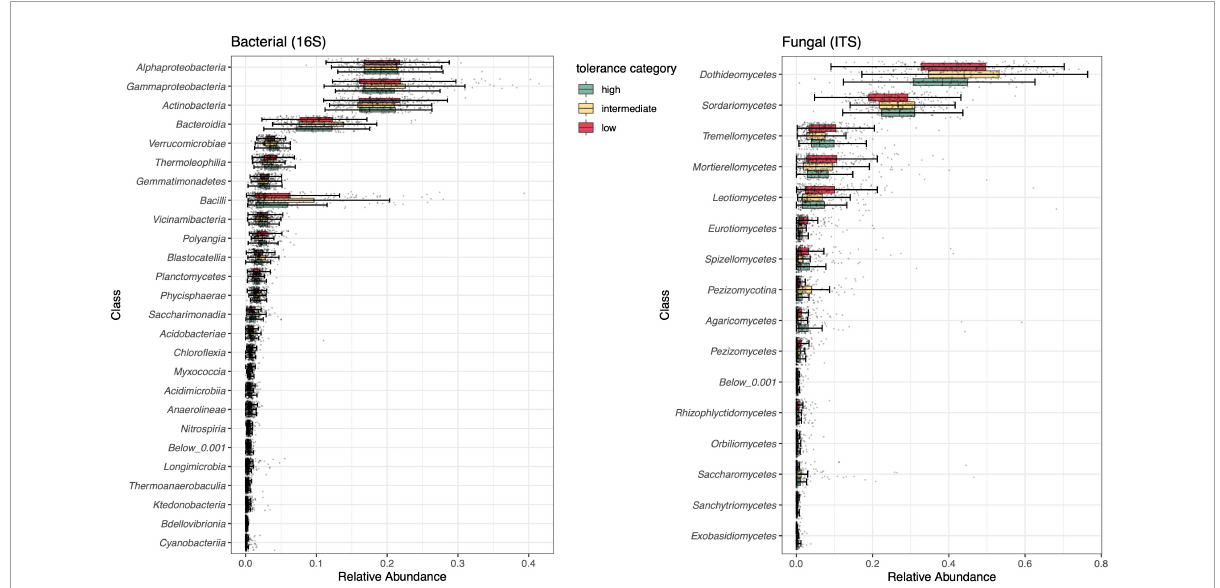
FIGURE5 Summary of class-level rhizosphere composition of bacterial (left) and fungal (right) communities compared across tolerance categories (high, intermediate, low). Individual taxa (ASVs) were grouped by class, displayed on the y -axis. Low abundance classes ( < 0.001%) were grouped together in a single category. n = 38–40 for all